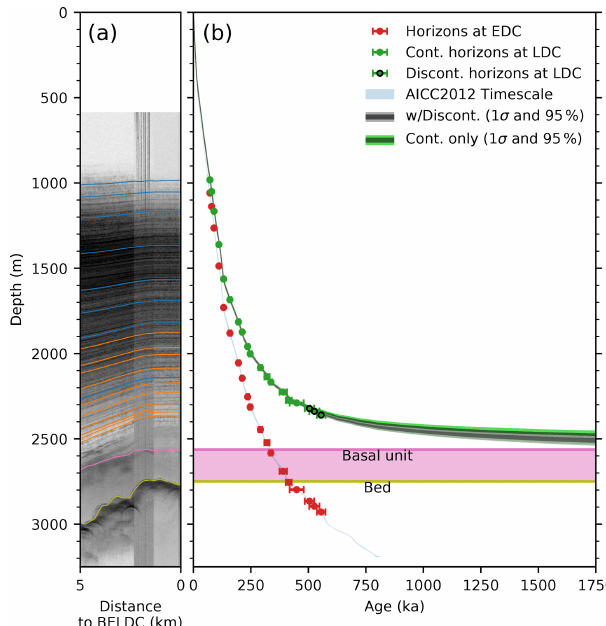
Figure 3. (a) Radargram near BELDC (as in Fig. 2). (b) Depth–age scale at BELDC and EDC. Dots with error bars show traced hori- zons with age uncertainties; blue line shows AICC2012 chronology (Bazin et al., 2013). The gray shaded regions show model results utilizing constraints from all horizons at 95% confidence (light) and 1 σ (dark). Green shaded region shows the model results with the discontinuous horizons excluded from the